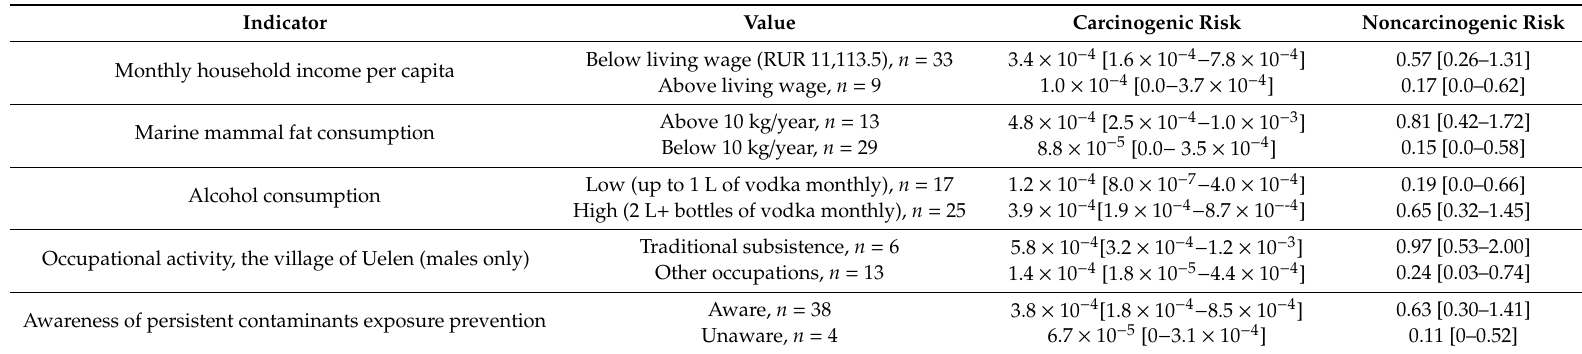
Table 4. Calculated PCB-related cancer risks due to the consumption of traditional foods in relation to social variables (village of Uelen, 2010).